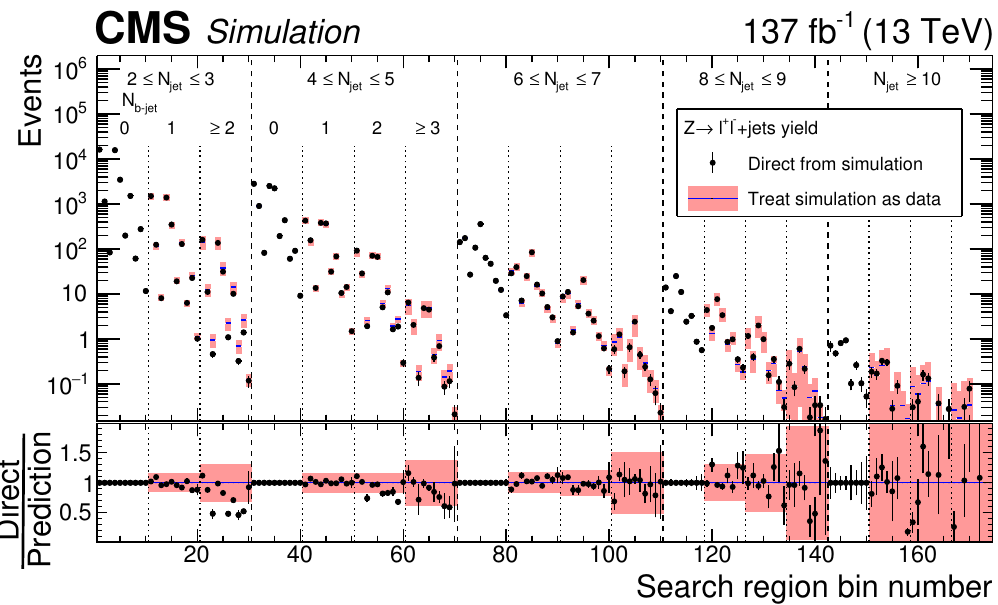
Figure 7 . Prediction from simulation for the Z( ! ‘ + ‘ (cid:0) )+jets event yields in the 174 search bins as determined by computing the F data factors (eq. (7.3)) and the N = 0 event yields in the j ; b b-jet same manner as for data, in comparison to the corresponding direct Z( ! ‘ + ‘ (cid:0) )+jets prediction from simulation. The 10 results (8 for N (cid:21) 8) within each region delineated by vertical dashed jet lines correspond sequentially to the 10 (8) kinematic intervals in H and H miss T T and (cid:12)gure 3. For bins with N (cid:21) 10, some points do not appear in the upper panel because they jet lie below the minimum of the displayed range. In the case that the direct expected yield is zero, there is no result in the lower, ratio panel. The pink bands show the statistical uncertainties in the prediction, scaled to correspond to the integrated luminosity of the data, combined with the systematic uncertainty attributable to the kinematic ( H and H miss ) dependence. The black error T T bars show the statistical uncertainties in the simulation. For bins corresponding to N = 0, the b-jet agreement is exact by